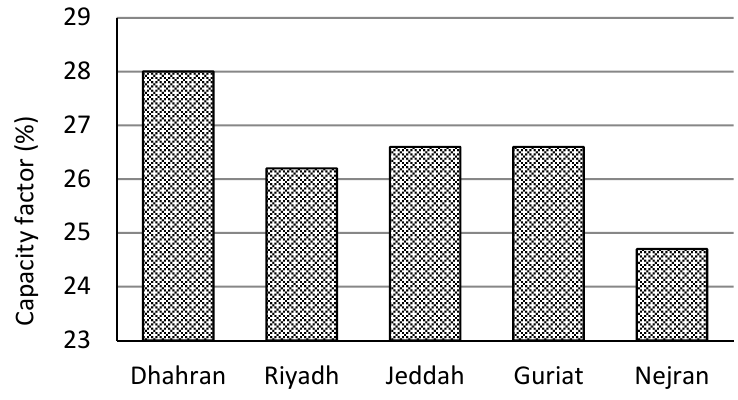
Figure 12. Achieved capacity factor for all sites.